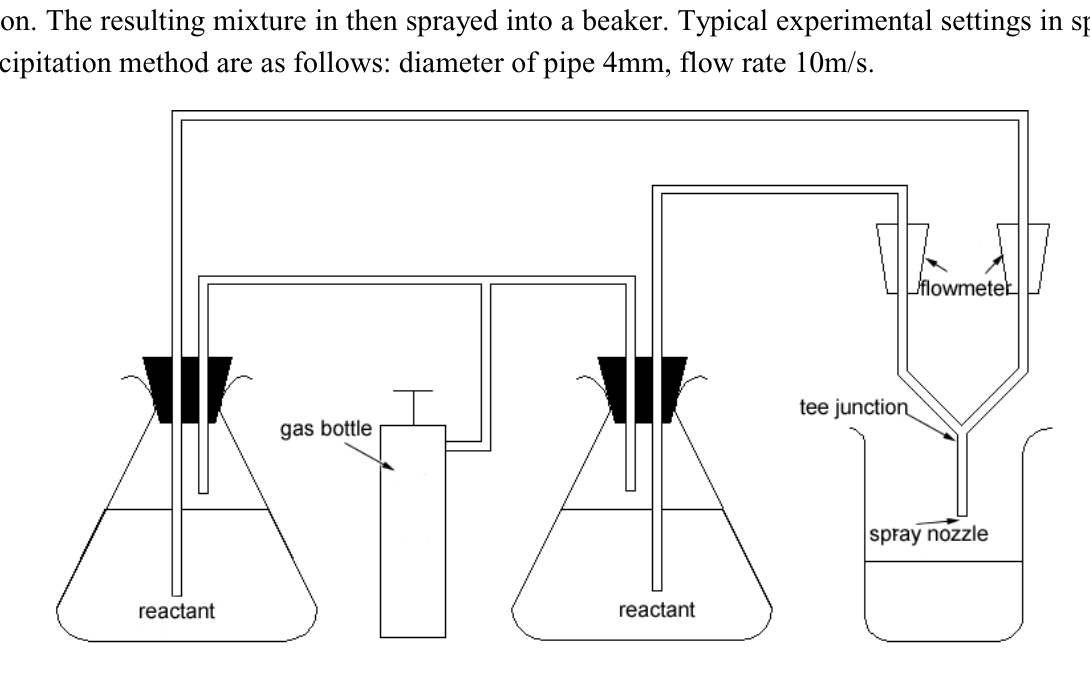
Figure 1. Scheme of spraying